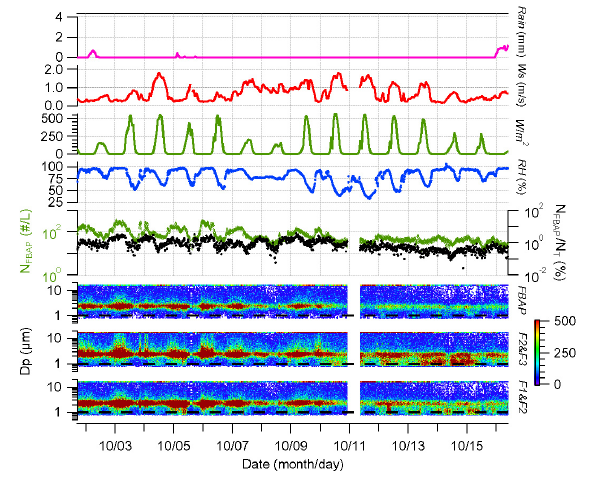
Fig. 15. WIBS-4 fluorescence data for a selected time period during winter season in comparison with meteorological data measured at the same time. The data were plotted in the same way as in Fig.